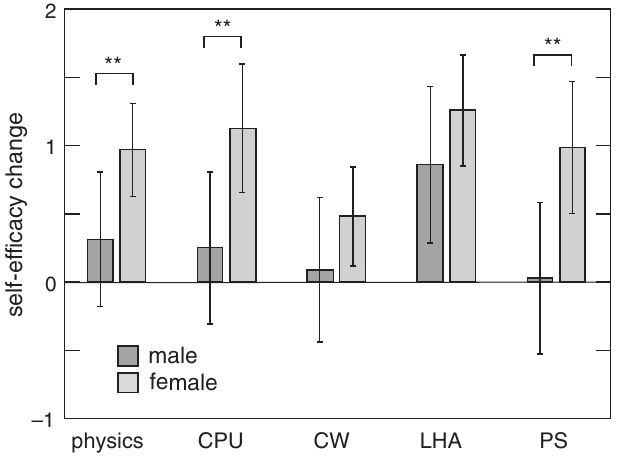
FIG. 2. Self-efficacy change (overall and in each of the four dimensions) over the course of the semester for male (dark gray) and female (light gray) students. Data from both semesters (2016 and 2017) have been combined. Error bars represent the standard errorofthe mean;errorbarsthatcross theaxisindicateachangethat is not statistically different from zero. ** p < 0 . 01 statistical significance of difference between male and female students. Abbreviations for the sources of self-efficacy are as shown in the text.